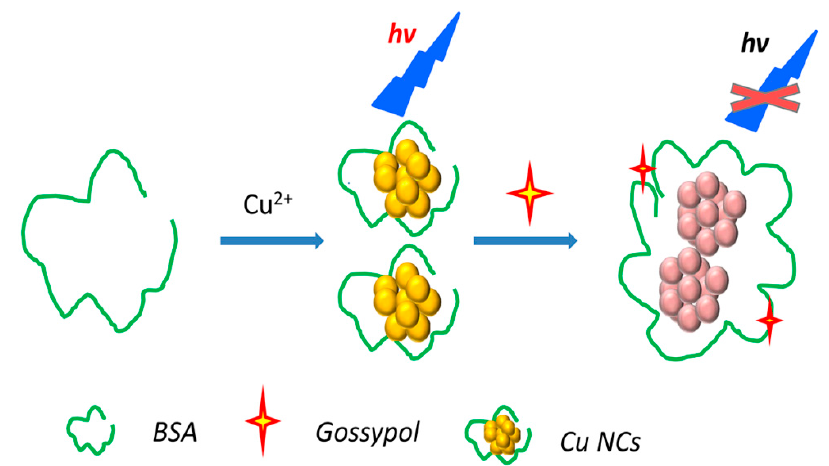
Figure 5. Scheme illustrating the fluorescence sensing mechanism.